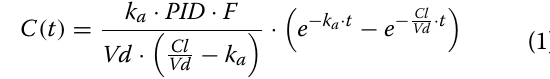
VPA/lactate paired values were considered. The relation- ship of blood lactate level (E) as function of plasma VPA concentration (C) estimated from Eq. 1 was described using the exponential growth equation: